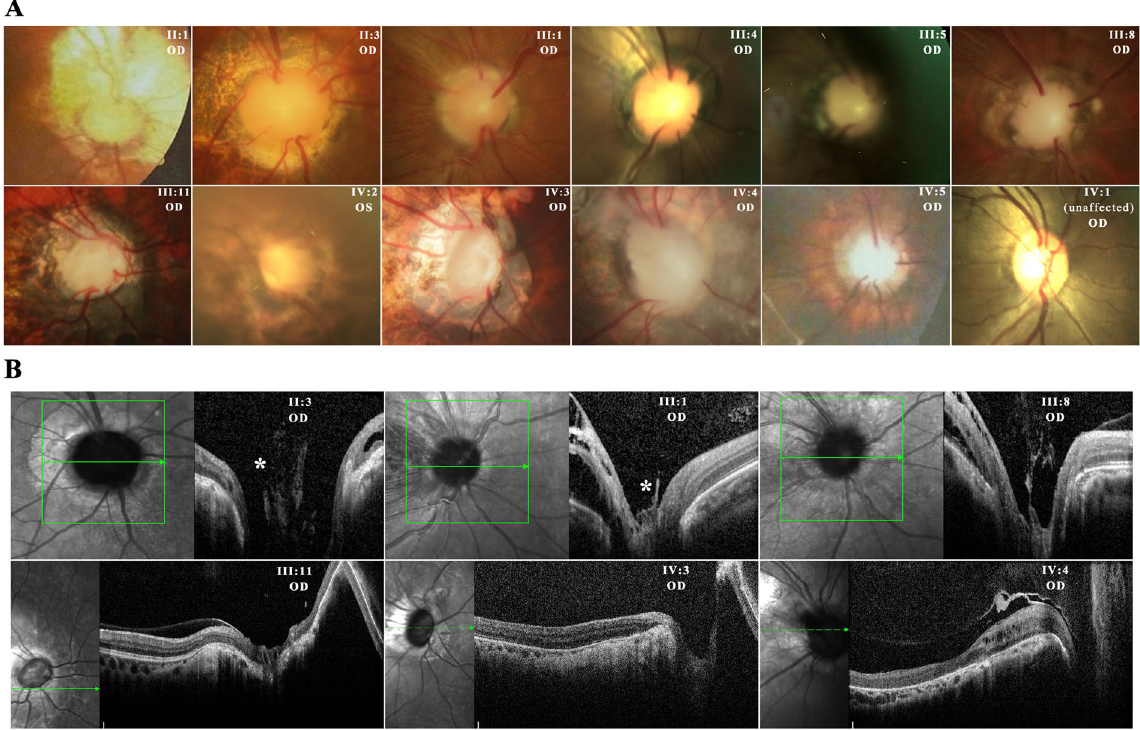
Figure 2. Fundus photos and SD-OCT images suggest ONH anomalies in patients from family CL. ( A ) Fundus photos of 11 affected individuals (II:1, II:3, III:1, III:4, III:5, III:8, III:11, IV:2, IV:3, IV:4, and IV:5) revealed pale- appeared ONH, enlarged excavation with poor defined optic disc rim, and several cilioretinal vessels emanated from the edge of the vacant optic disc. No central retinal artery/vein trunk was observed. ONH of the unaffected member IV:1 was shown as control. OD, right eye; OS, left eye. ( B ) SD-OCT of six affected members (II:3, III:1, III:8, III:11, IV:3, and IV:4) showed steep cupping with glial tissue (indicated by asterisk). Green arrowed lines denote scanned axis by